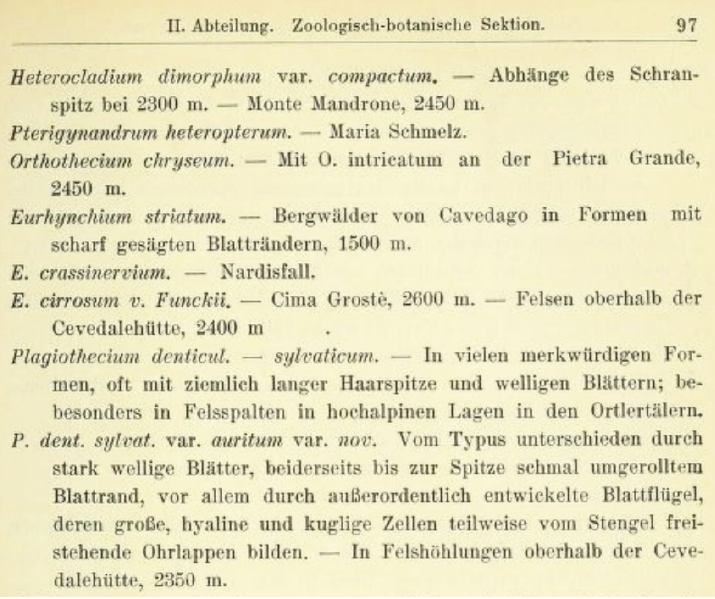
Figure 12. Type of P. denticulatum var. auritum (PC0132639), photo by G.J. Wolski, Paris, November 2021.